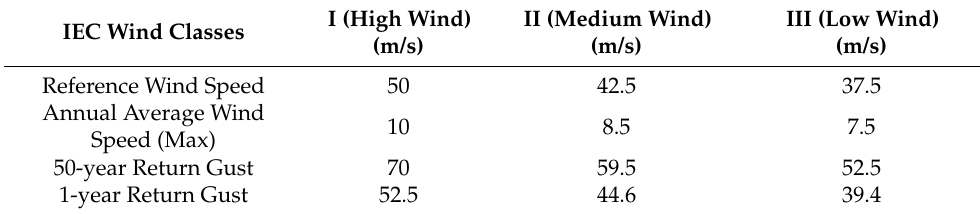
Table 2. IEC wind class standard [52].